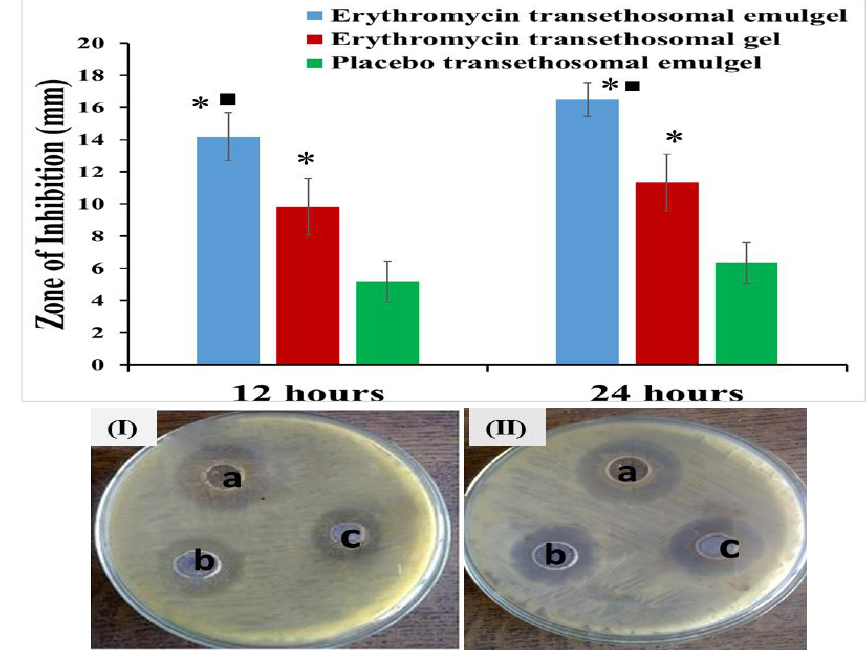
Figure 8. Comparative antimicrobial results of ( a ) Erythromycin-loaded transethosomal emulgel (EM-TE-Emulgel), ( b ) Erythromycin-loaded transethosomal gel (EM-TE-Gel) and ( c ) placebo transethosomal emulgel against S. aureus after 12 h ( I ) and 24 h ( II ). Results are represented as mean ± SD (n = 3). * compared to placebo transethosomal emulgel ( p < 0.05); and ■ compared to Erythromycin transethosomal gel ( p < 0.05).